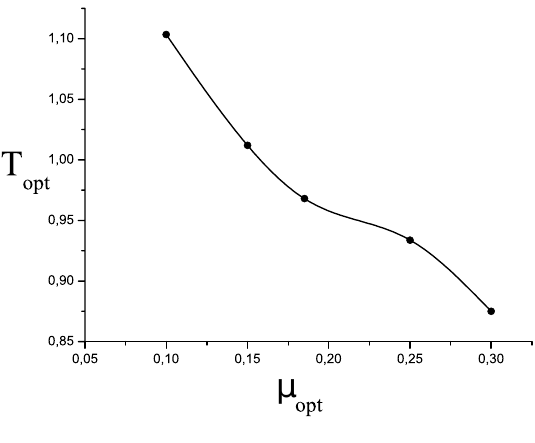
Fig. 4. Optimal values of mass ratio.